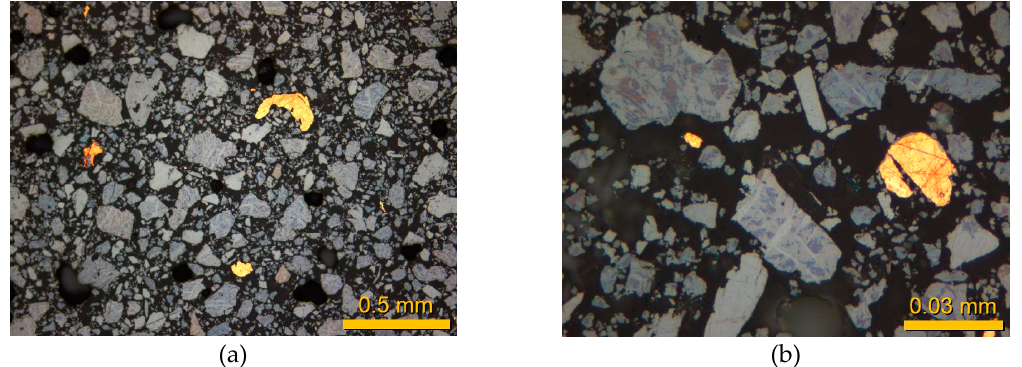
to the white metal with mapping to 200×.